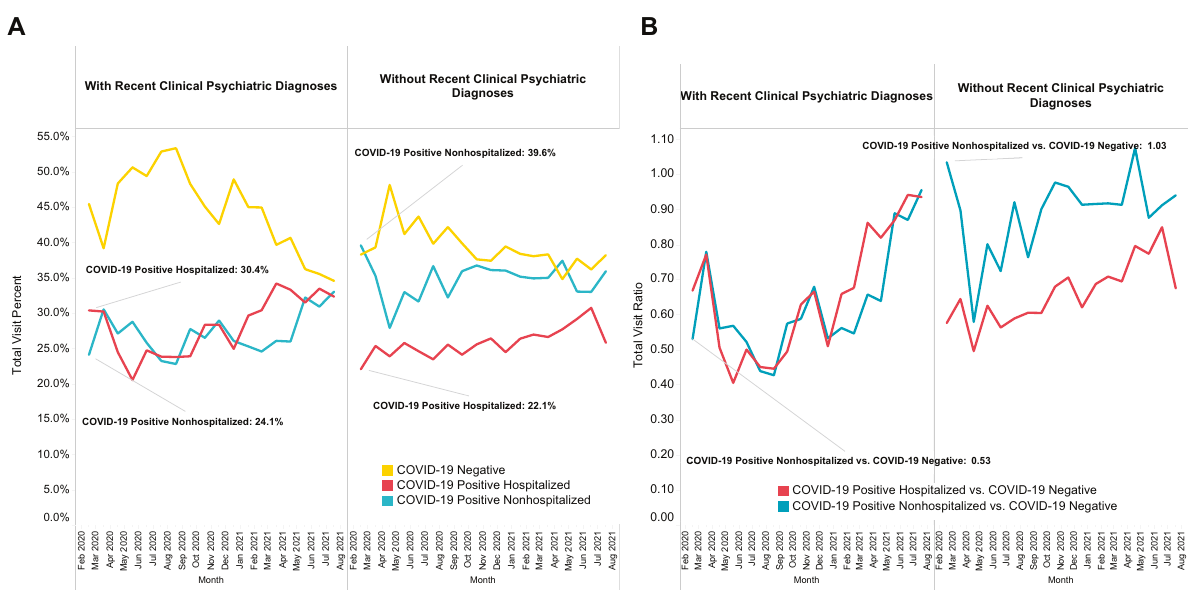
Fig. 2 Trends of COVID-19 infection and hospitalization status by recent clinical psychiatric diagnoses. A Comparing total visit percentage. B Comparing total visit